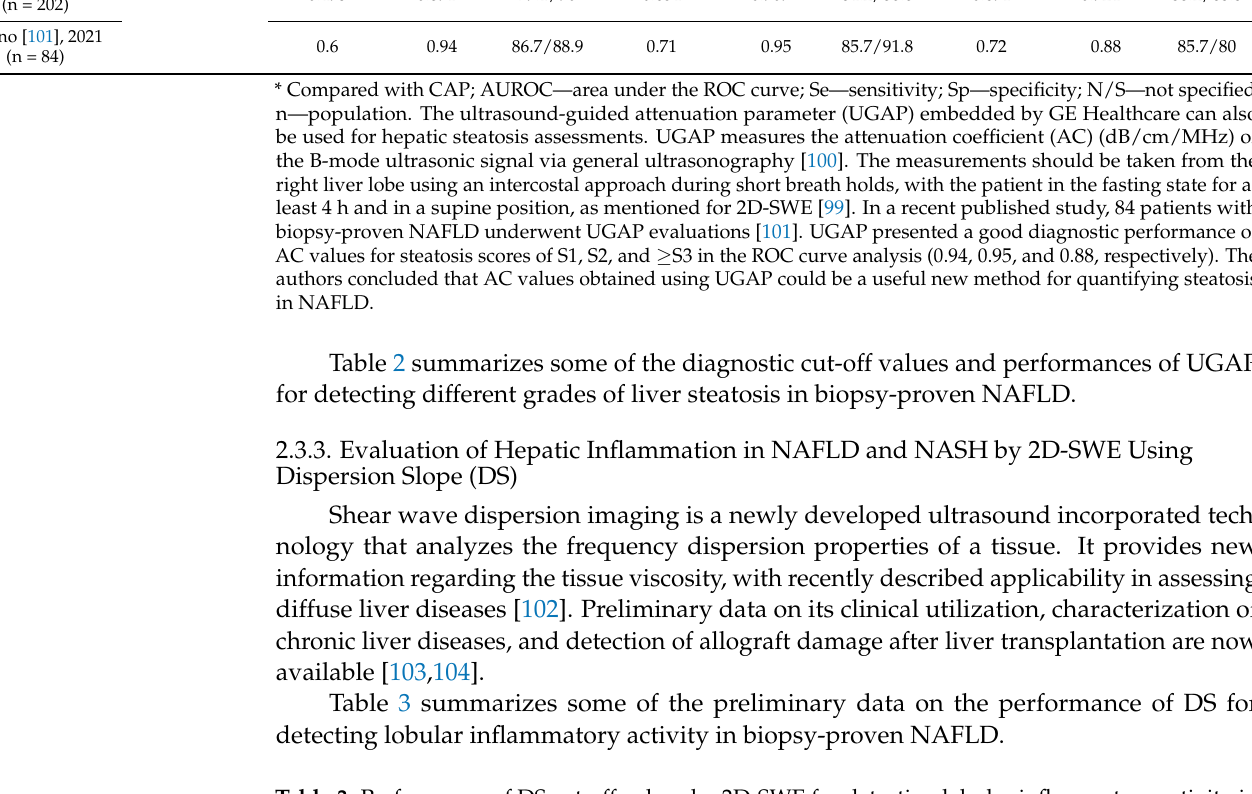
Table 3. Performance of DS cut-off values by 2D-SWE for detecting lobular inflammatory activity in biopsy-proven